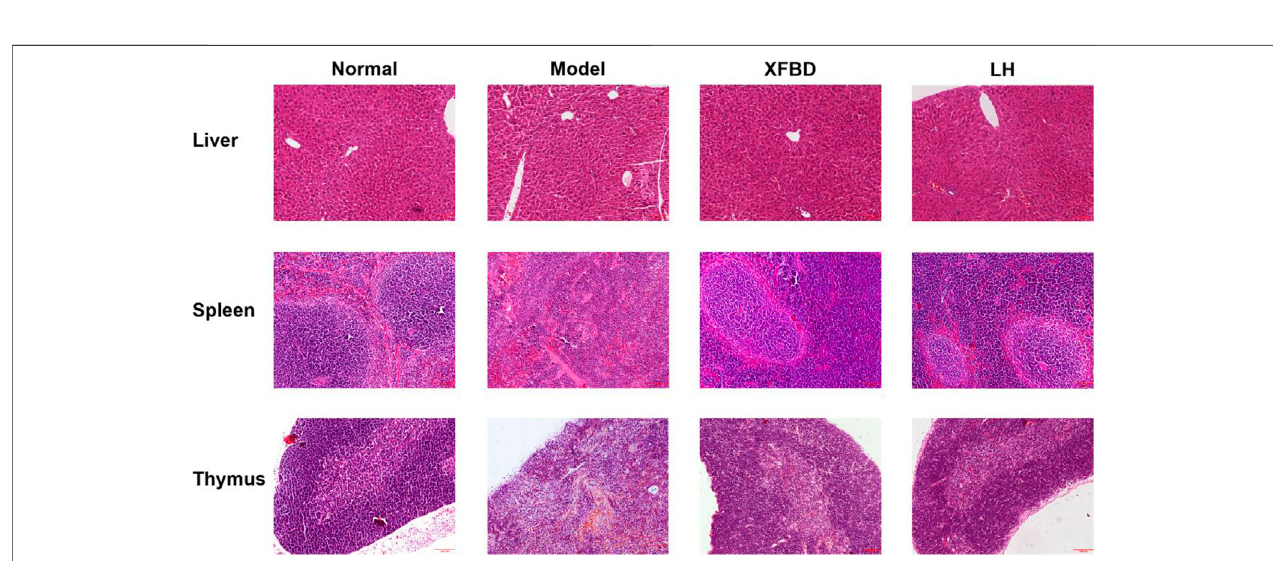
FIGURE 2 | Effects of XFBD on the morphological changes in the liver, the spleen, and the thymus in CY-treated mice. stained by H&E, 10 × Normal, administered with saline; Model: intraperitoneally administered with cyclophosphamide; XFBD: intraperitoneally administered with cyclophosphamide fi rst and followed by XFBD at 3.9 g/kg/day; and LH: intraperitoneally administered with cyclophosphamide fi rst and followed by LH at 20